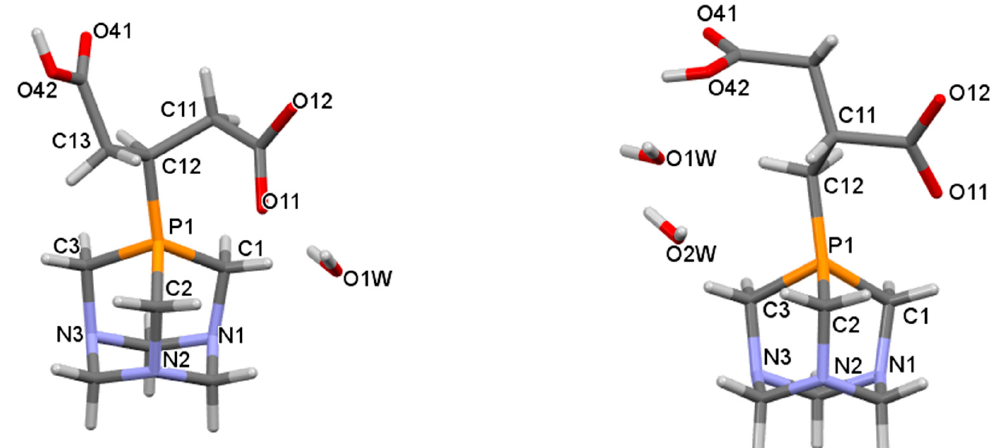
Figure 4. Capped stick representation of 1 × H 2 O ( left ) and 2 × 2H 2 O ( right ) with partial atom numbering. Selected bond lengths and angles are shown in Table S2.